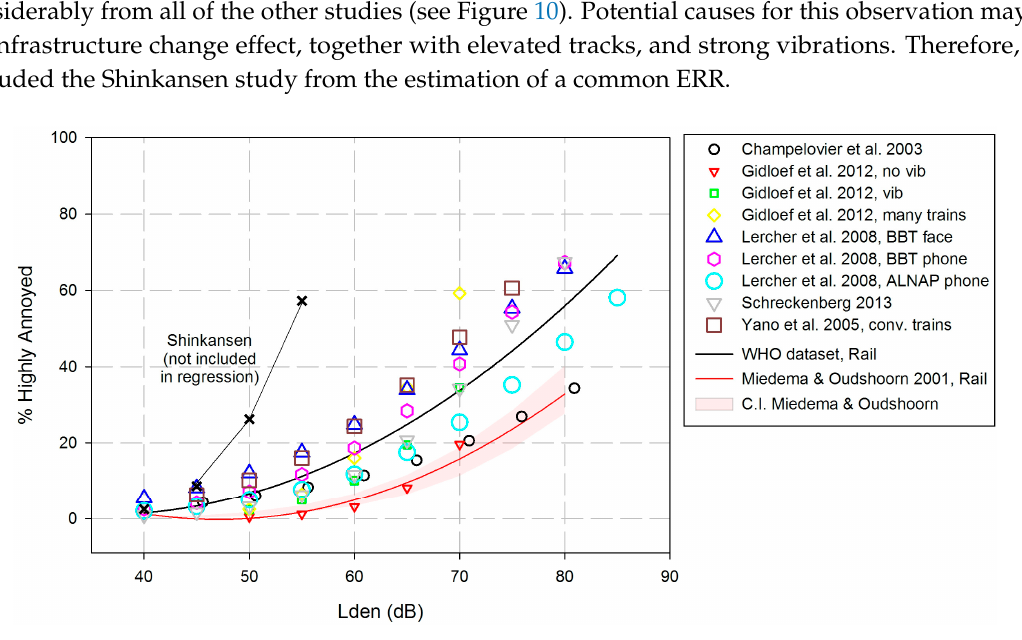
Figure 10. Scatterplot of the relation between L den and %HA including ten railway noise studies. The quadratic regression (black line) was calculated excluding the Shinkansen data. In addition, the exposure ‐ response function by Miedema and Oudshoorn ([4], railway, red curve) is shown together with the confidence interval. Notes: (1) The size of the data points corresponds to the number of participants in the respective study (size = SQRT(N)/10). (2) If two results from different studies fall on the same data point, the last point plotted may mask the former one. (3) The black curve is derived from aggregated data, while the red one is derived from individual data.